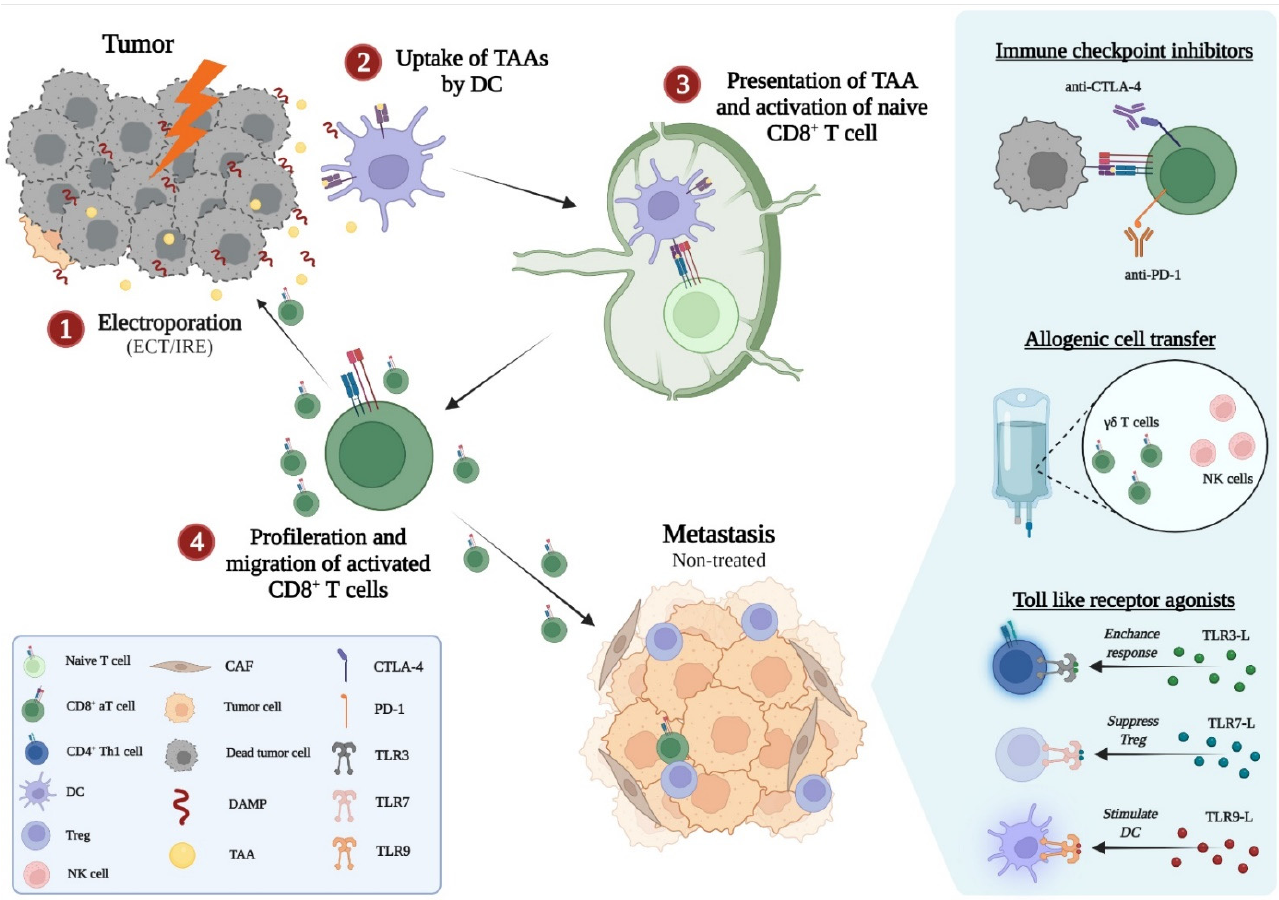
Figure 3. Model of how electroporation may induce an immune response and elicit an abscopal effect when combined with immunotherapy. aT cell, activated T cell; CAF, cancer-associated fibroblast; CTLA-4, cytotoxic T lymphocyte antigen 4; DAMP, damage-associated molecular pattern; DC, dendritic cell; ECT, electrochemotherapy; IRE, irreversible electroporation; NK cell, natural killer cell; PD-1, programmed death receptor 1; PD-L1, programmed death-ligand 1; TAA, tumor-associated antigen; TLR, Toll-like receptor; TLR3-L, TLR3 ligand; Treg, regulatory T cell. Created with BioRender.com (accessed on 7 June 2022).